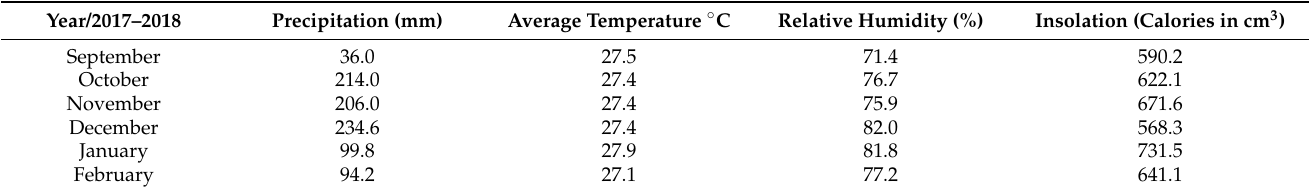
Table 7. Climate conditions observed from September 2017 to February 2018 throughout the